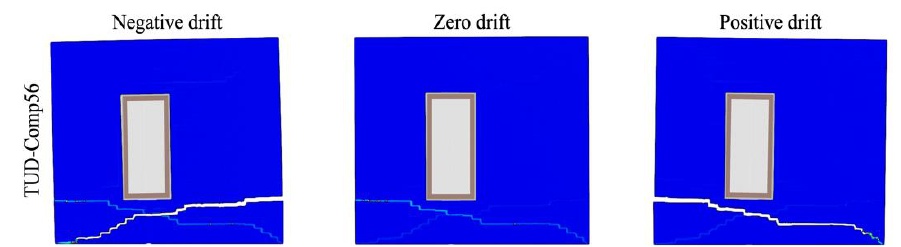
Figure 12. Deformed shape plots (500 times magnified) of the strengthened wall (TUD-Comp56) resulting from the SLS protocol at a displacement of 2.125 mm (0.085% drift).